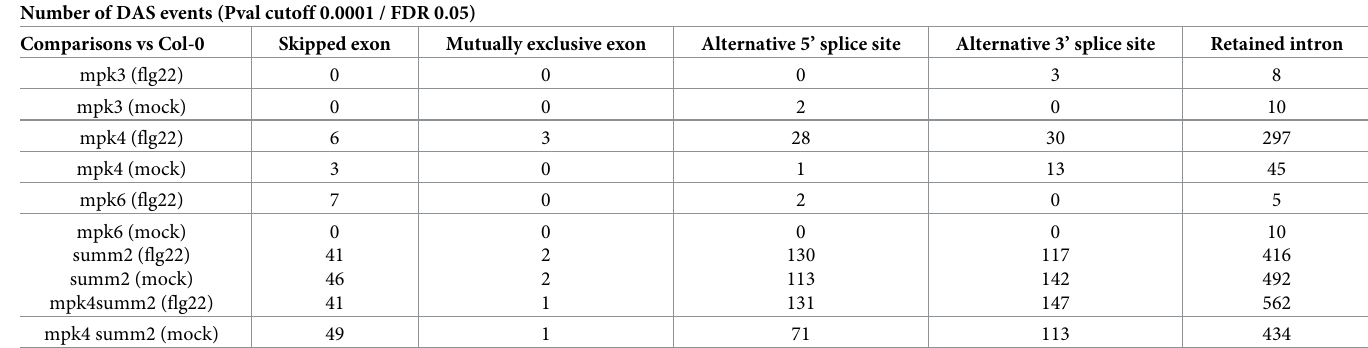
Table 2. Number of DAS events in mpk3 , mpk4 , mpk6 , summ2 and summ2mpk4 as compared to Col-0 upon mock (H 2 O) or flg22 treatment. Number of DAS events (Pval cutoff 0.0001 / FDR